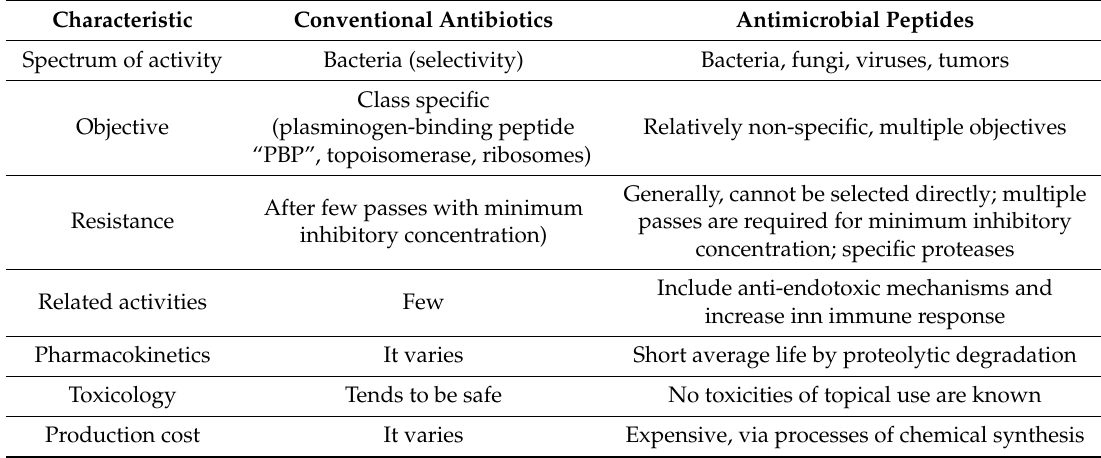
Table 5. Properties that characterize antibiotics and antimicrobial peptides [68].